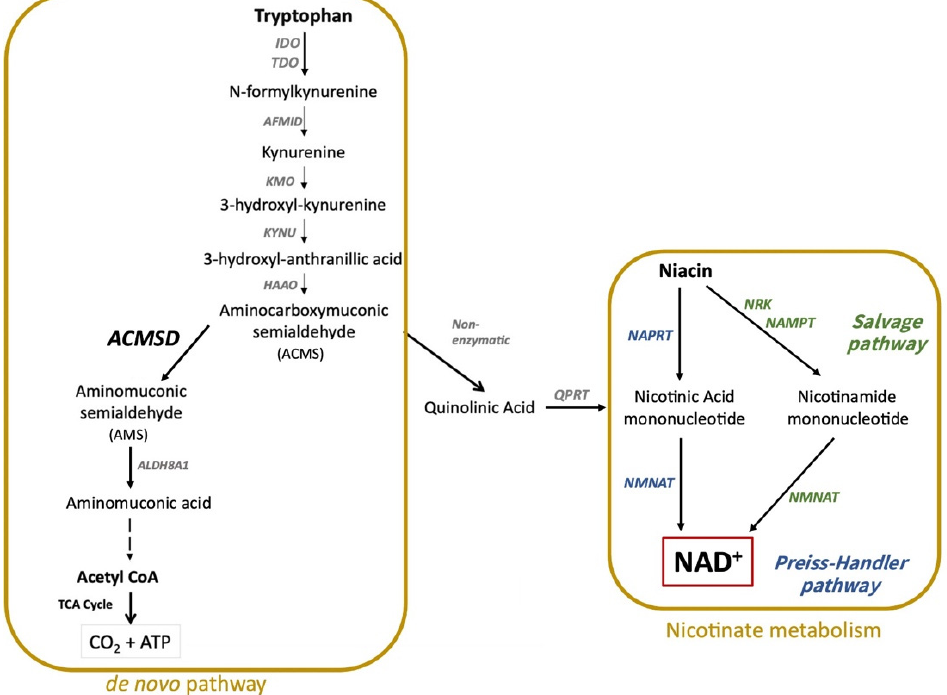
Figure 1. Brief summary of NAD + biosynthesis pathways. NAD + biosynthesis includes the de novo pathway (starts from dietary tryptophan) and nicotinate metabolism (Preiss-Handler pathway in blue and Salvage pathway in green, starts from niacin). Niacin includes nicotinamide, nicotinic acid, and nicotinamide riboside. Dietary tryptophan can be converted to either NAD + or acetyl-CoA via the kynurenine metabolic pathway in mammals. ACMSD is the key enzyme that can moderate NAD + homeostasis. Abbreviations: ACMSD, ACMS decarboxylase; AFMID, N-formylkynurenine formamidase; ALDH8A1, 2-aminomuconic semialdehyde dehydrogenase; CoA, coenzyme A; HAAO, 3-hydroxyanthranilate 3,4-dioxygenase; IDO, indoleamine 2,3-dioxygenase; KMO, kynurenine 3-monooxygenase; KYNU, kynureninase; NAD + , nicotinamide adenine dinucleotide; NAMPT, nicotinamide phosphoribosyltransferase; NAPRT, nicotinic acid phosphoribosyltransferase; NMNAT, nicotinamide mononucleotide adenylyltransferase; NRK, nicotinamide riboside kinase; QPRT, quinolinate phosphoribosyl transferase; TCA cycle, tricarboxylic acid cycle; TDO, tryptophan 2,3-dioxygenase.